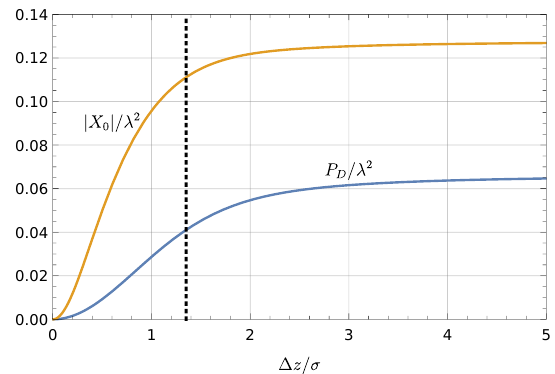
Figure 3. The nonlocal correlation term | X 0 | and the transition probability P D are plotted as a function of the distance between the rest detectors and the boundary, ∆ z . The vertical dashed line ( ∆ z/σ ≈ 1 . 352 ) indicates where the maximum difference between | X 0 | and P D occurs. Here, we have set the energy gap Ω σ = 0 . 10 and the separation between such two rest detectors ∆ d/σ = 1 . 00